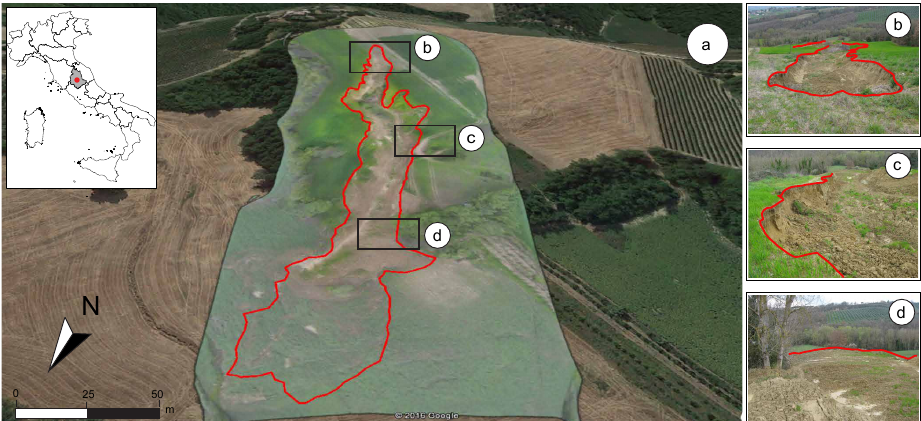
Figure 1. The Assignano landslide, located near Collazzone, Umbria, central Italy. (a) Global view of the landslide. (b) Detail of the landslide source area. (c) Detail of the landslide transportation area. (d) Detail of the landslide deposit. Base image obtained overlaying (“draping”) the image on Google Earth ™ . The red line is the boundary of the landslide obtained using the RTK dGPS